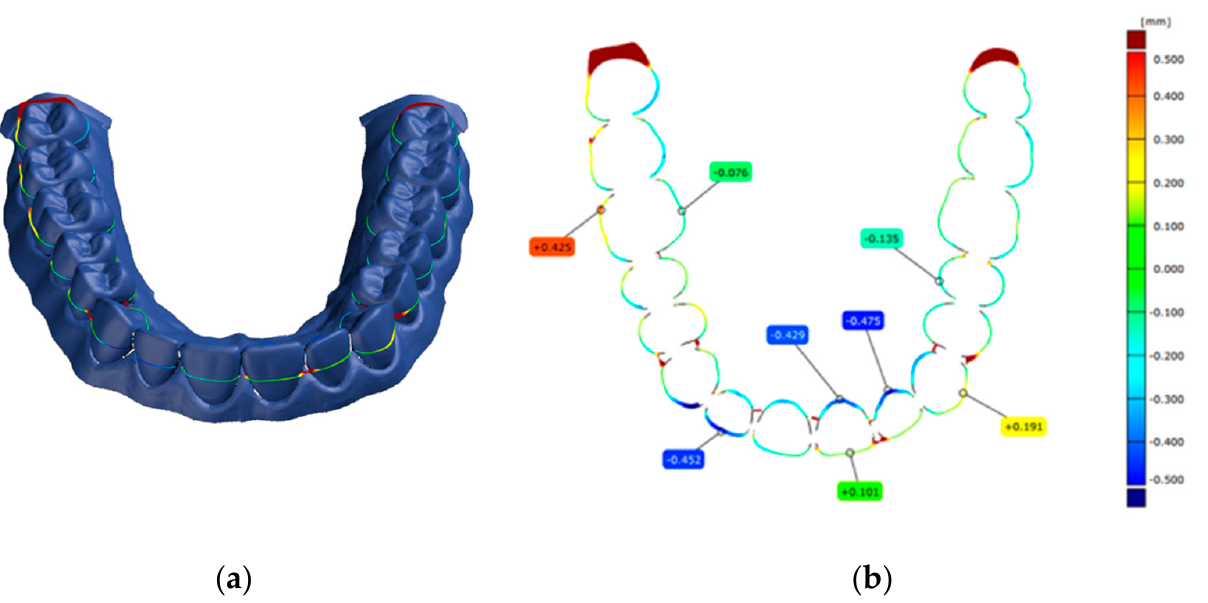
Figure 6. Section plans used for planned measurements ( a ) and measurements performed during the study ( b ).